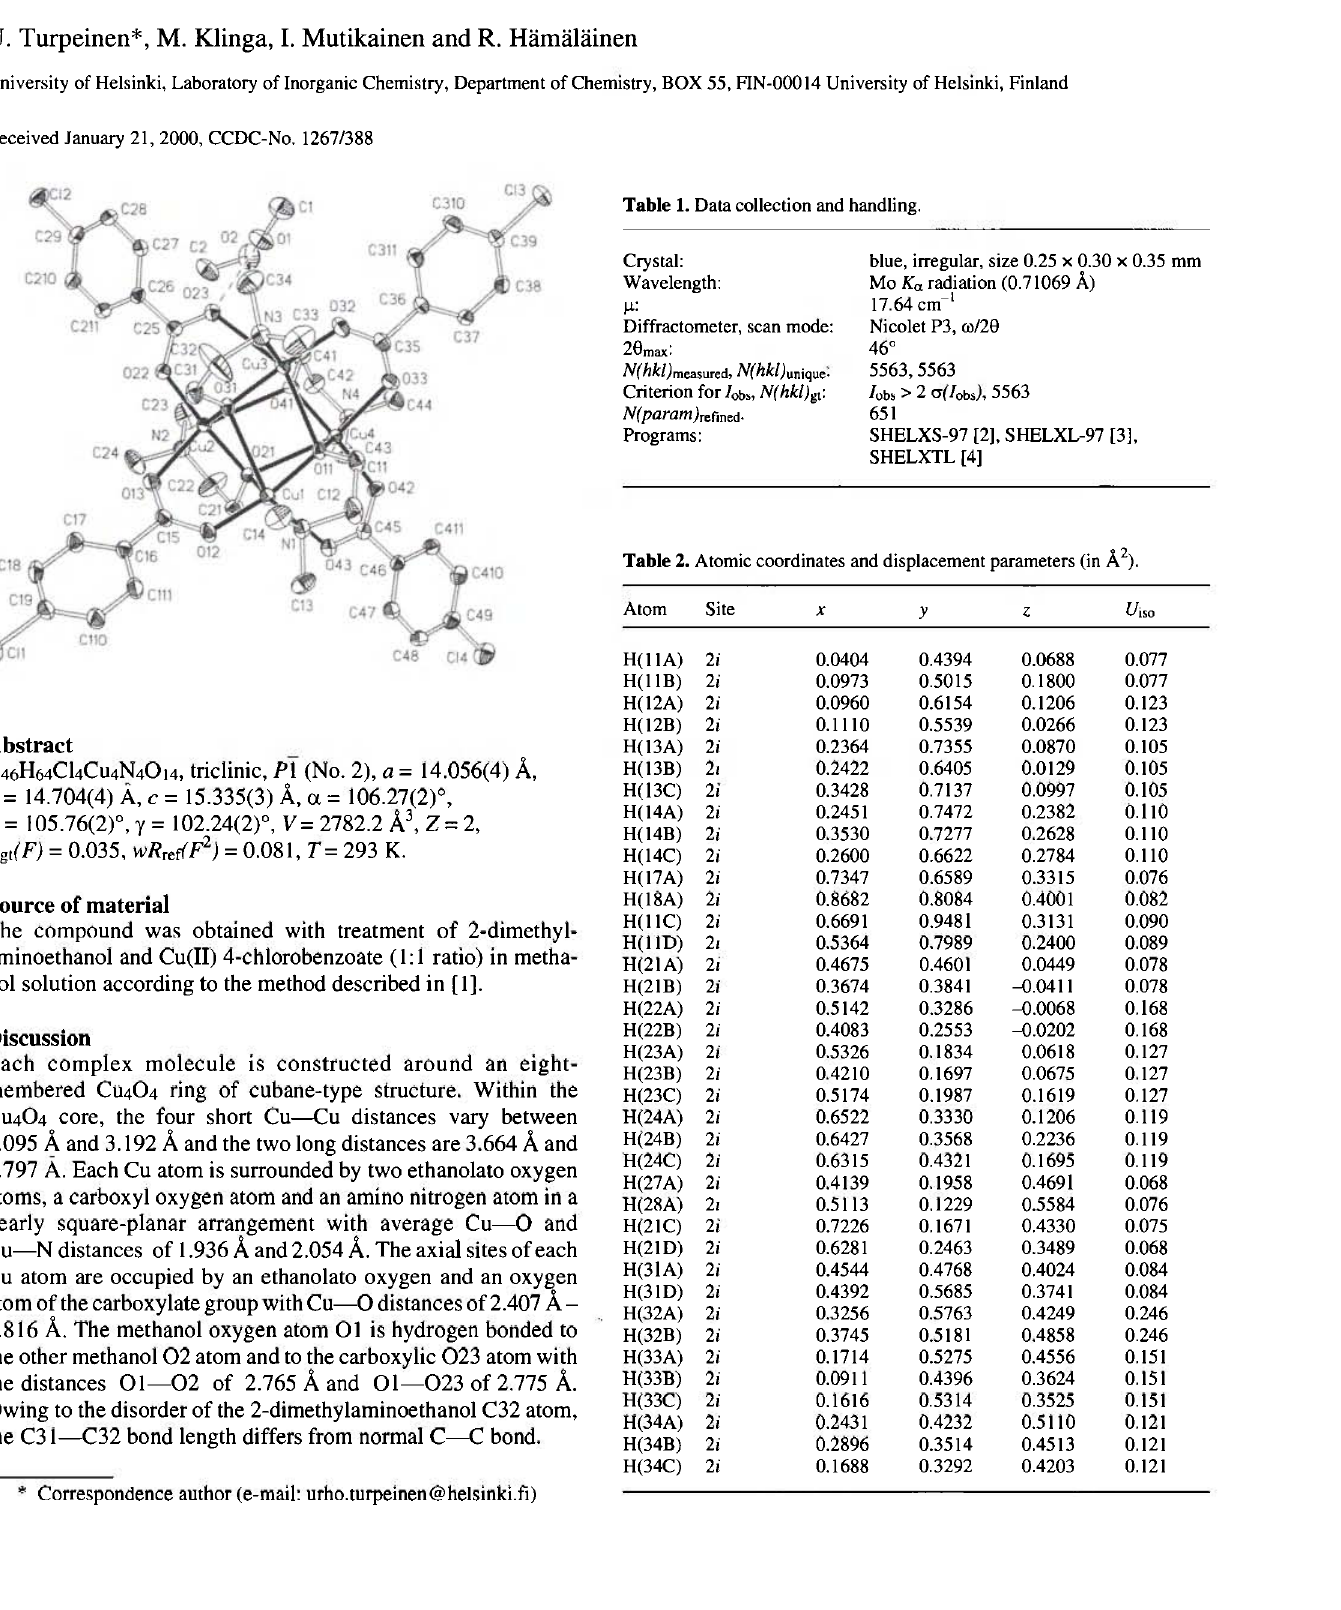
Table 1. Data collection and handling.